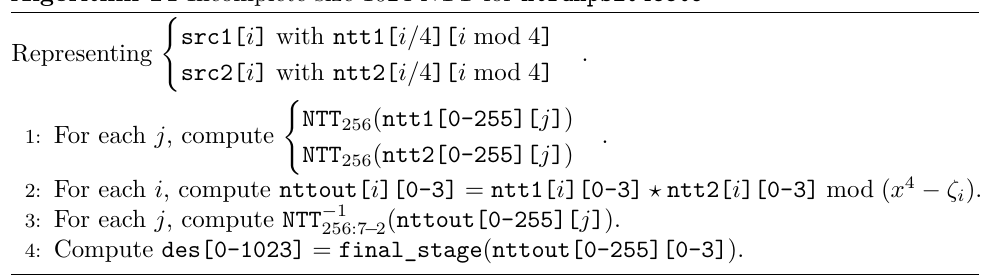
Algorithm 14 Incomplete size-1024 NTT for ntruhps2048509